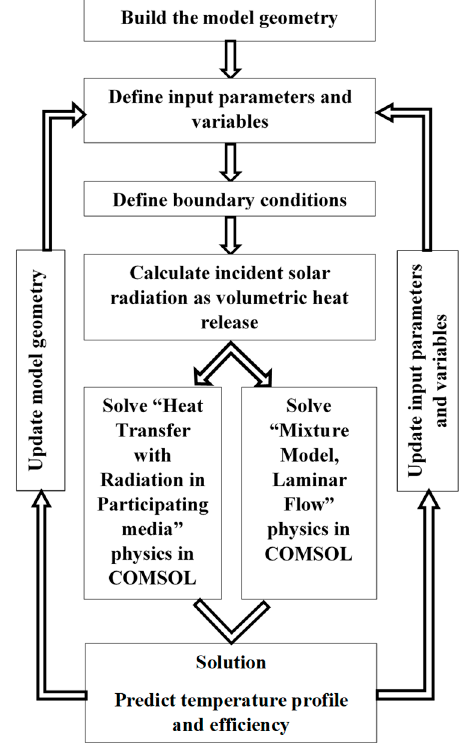
Figure 2. COMSOL Multiphysics modeling strategy.